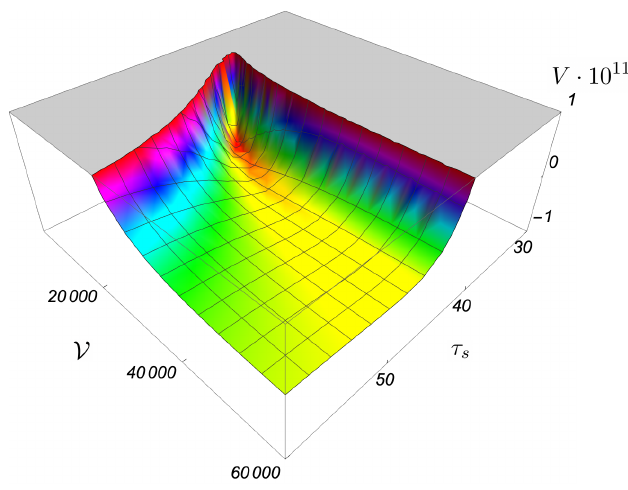
Figure 3 . New AdS minimum from ( α 0 ) 1 loop effects with α < 0 and parameter choice (B.15).